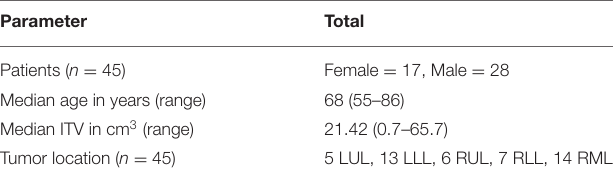
TABLE 2 | Patient and tumor characteristics.